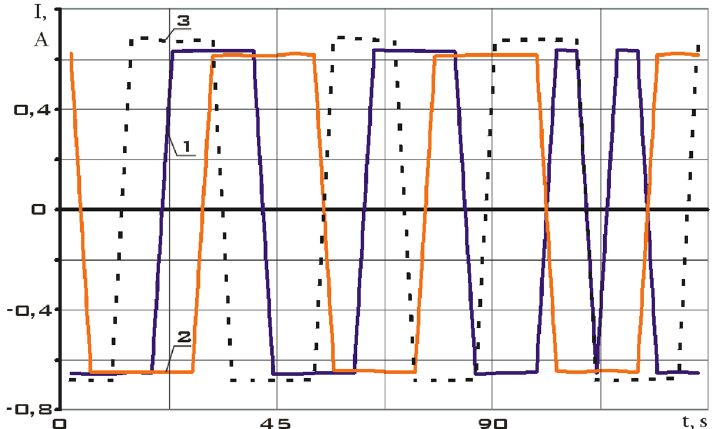
Figure 19. There is the current supplied to the magnetic actuators of the small spacecraft prototype "Aist" according to telemetry data from 02/15/2014 from 12:00:06 to 12:02:21. 1 is on an electromagnet, the axis of which is parallel to the CX axis; 2 is on an electromagnet, the axis of which is parallel to the CY axis; 3 is on an electromagnet, the axis of which is parallel to the CZ